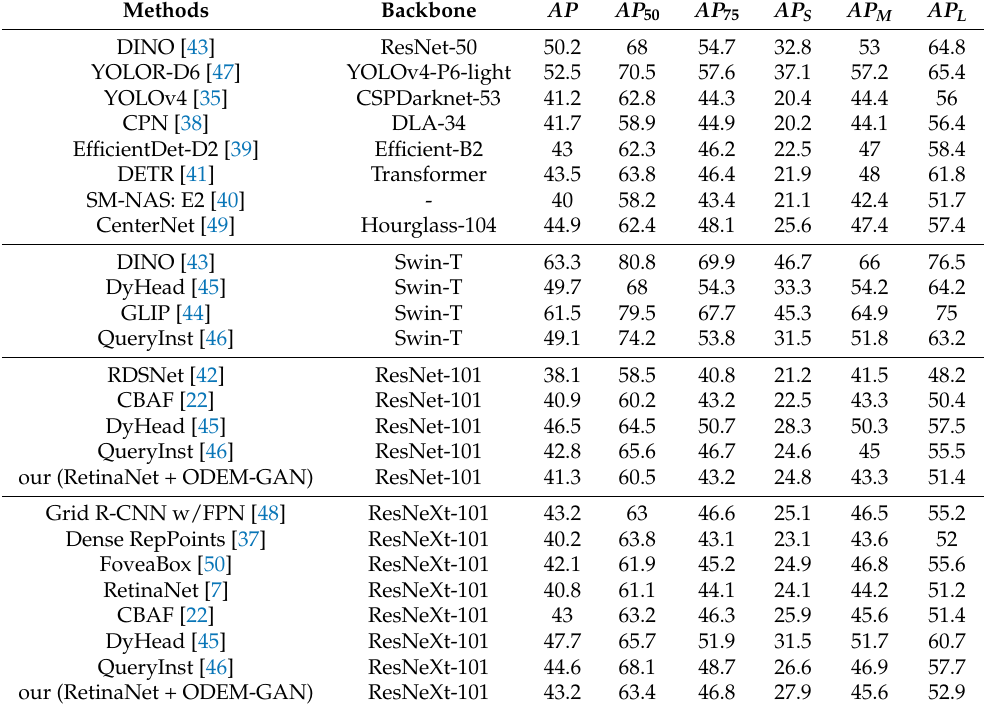
Table 8. Results of the comparison of our improved detector (RetinaNet with our ODEM-GAN module) and state-of-the-art